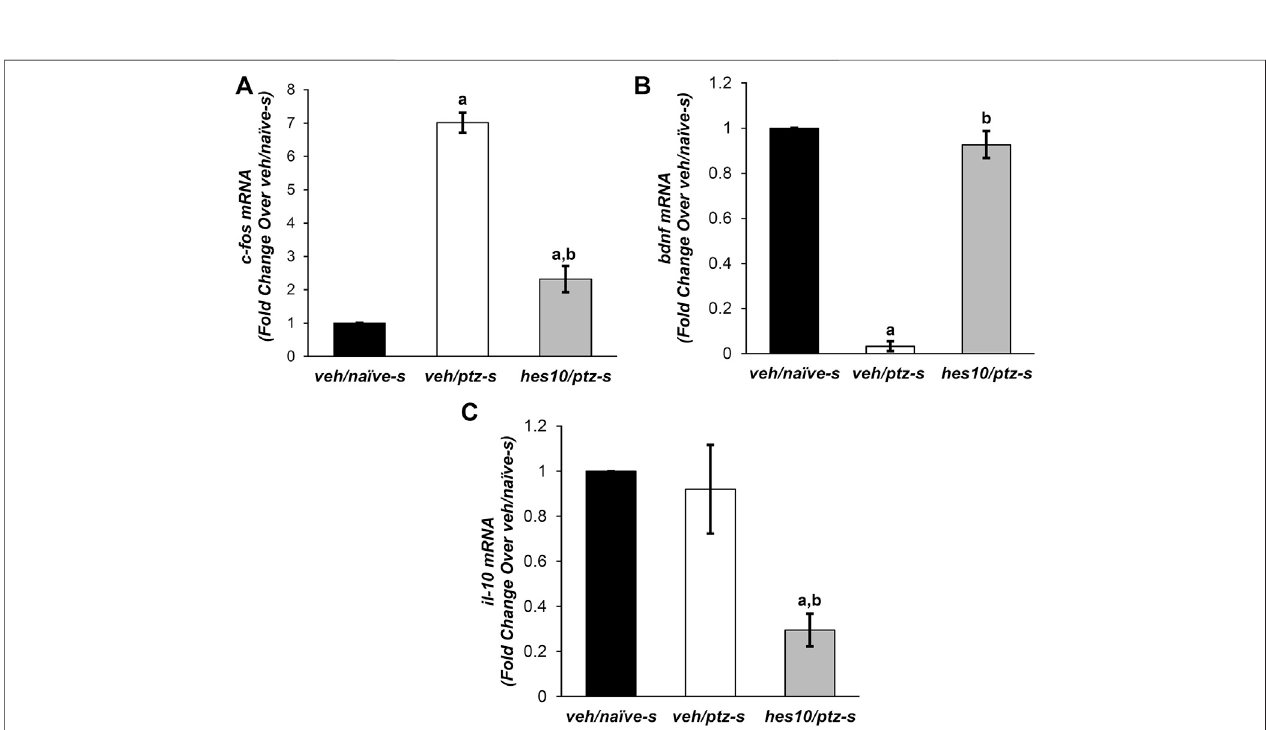
FIGURE5| EffectofhesperidinonPTZ-mediatedalterationsinmRNAlevelsof (A) c-fos , (B) bdnf ,and (C) il-10 . a P < 0.05ascomparedto veh/naive-s (naive)group and; b P < 0.05ascomparedto veh/ptz-s (vehiclecontrol).Theresultsexpressedasmean ± SD. veh/naïve-s :systemwaterincubatedgroupnotexposedtoPTZ; veh/ ptz-s : system water incubated group exposed to PTZ; and; hes10/ptz-s : Hesperidin 10 μ M incubated group exposed to PTZ.